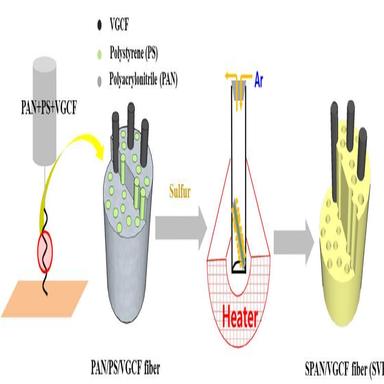
Schematic of the steps for fabricating the SVF composite.